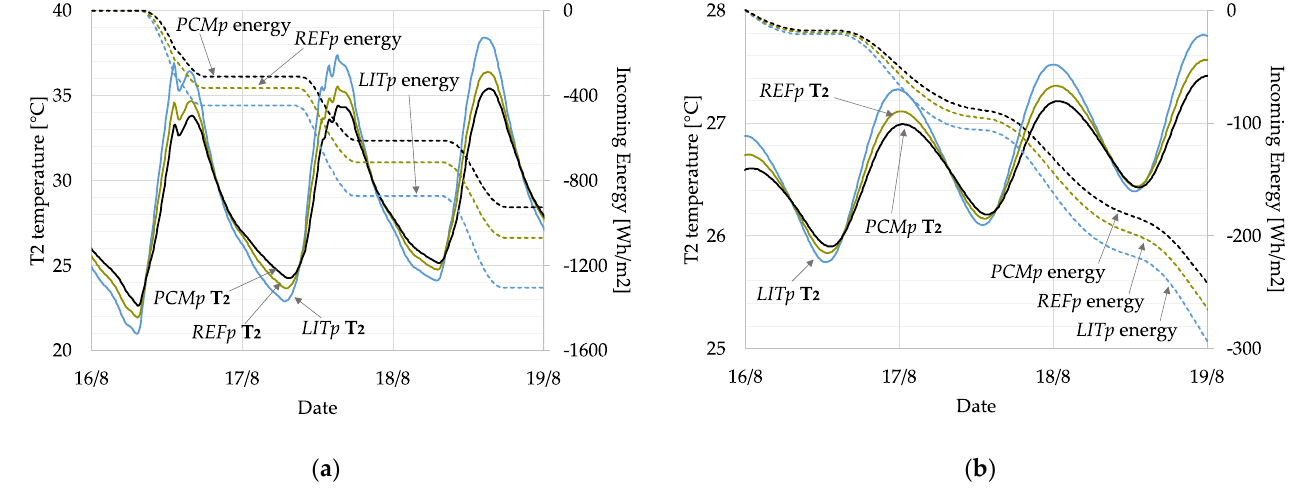
Figure 10. ( a ) Temperatures and incoming energy between the outer plaster and the 0.25 m brick layer (sensors T 2 and HF 5 ); ( b ) temperatures and incoming energy between the 0.25 m brick layer and the inner plaster (sensors T 3 and HF 6 ).